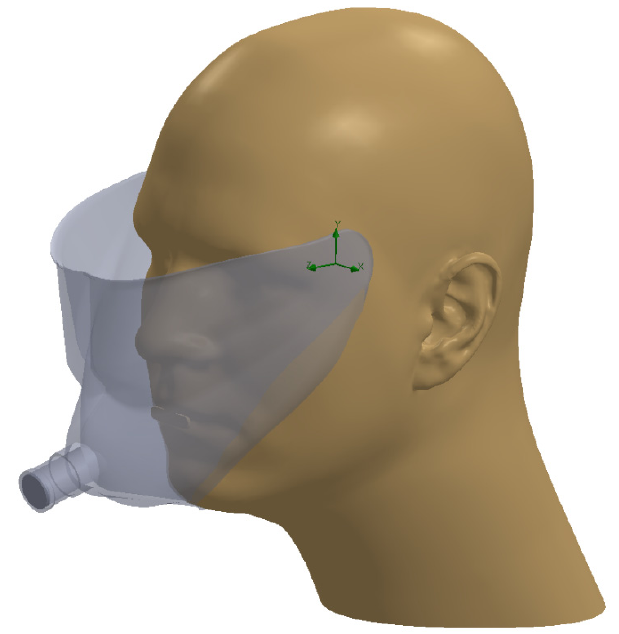
Figure 3. Solid model used for computational fluid dynamics simulations. Airflow is from the opening of the mask at the top through the dark grey outlet of the mask. Particle trajectories are initialized at the opening of the mouth.